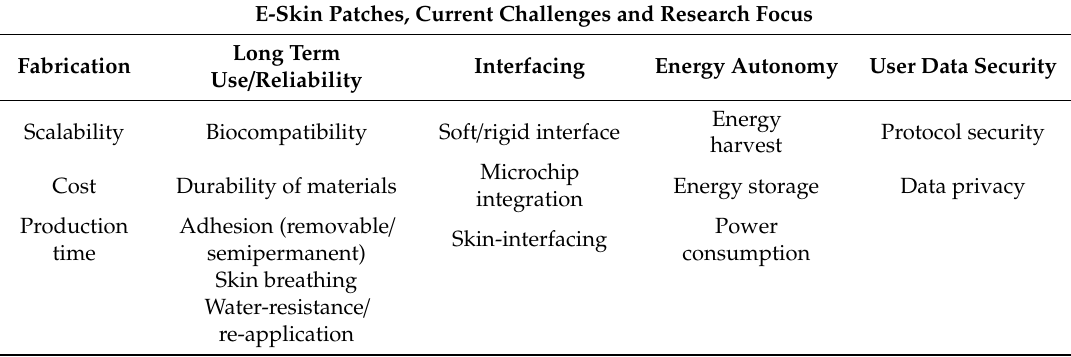
Table 3. Current challenges and research focus for e-skin